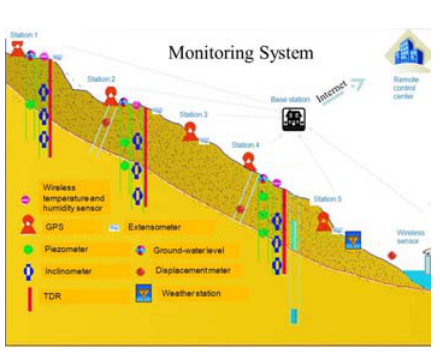
Figure 5. Longitudinal distribution of sensors